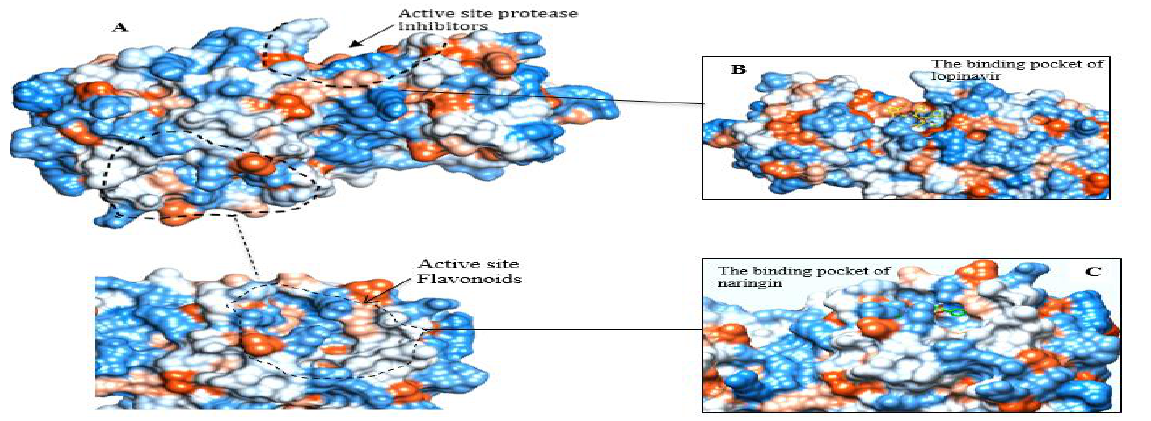
Figure 5. (A) The structure of COVID-19 main protease enzyme generated by using USCF Chimera with two active sites for flavonoids and protease inhibitors. (B) Ligand-protein interaction for lopinavir. (C) Ligand-protein interaction for